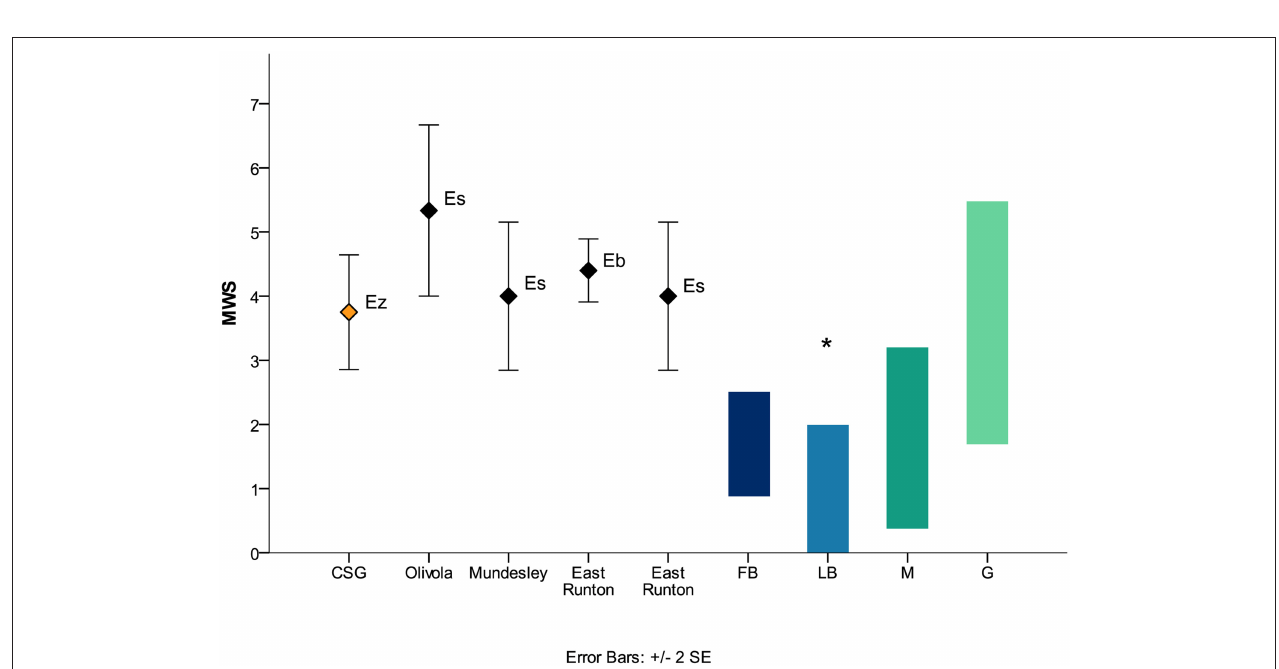
FIGURE 4 | Mesowear results of fossil stenonid equids and extant ungulates. Modern ungulates data from Fortelius and Solounias (2000) (diet information according to the radical classification; minute abraded brachydont species have been included), Rivals and Semprebon (2010). Mundesley and East Runton data from Rivals